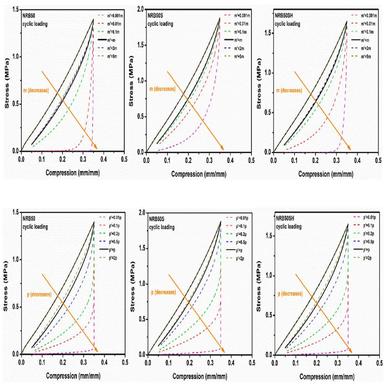
Effect of model parameters m and p on the unloading path for a compressive strain equal to 35%.